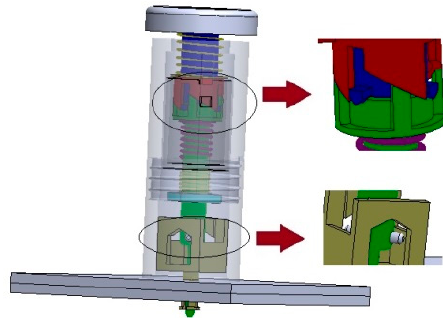
Figure 5. Schematic diagram of step 3.